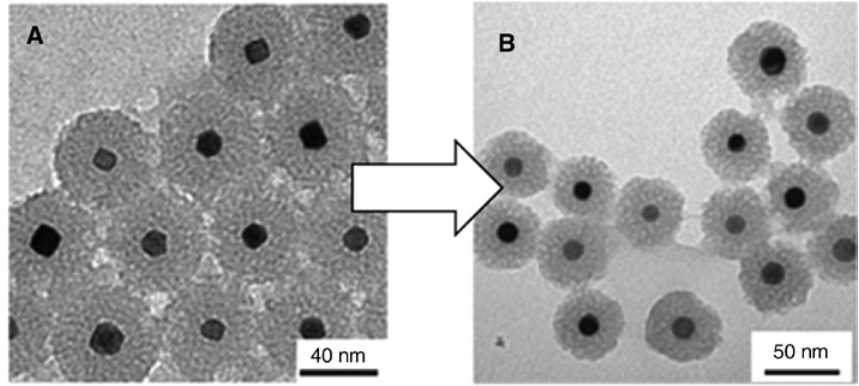
nanoparticles and (B) Pt@SiO nanoparticles after calcination at 550 ° C. Reprinted by 2 2